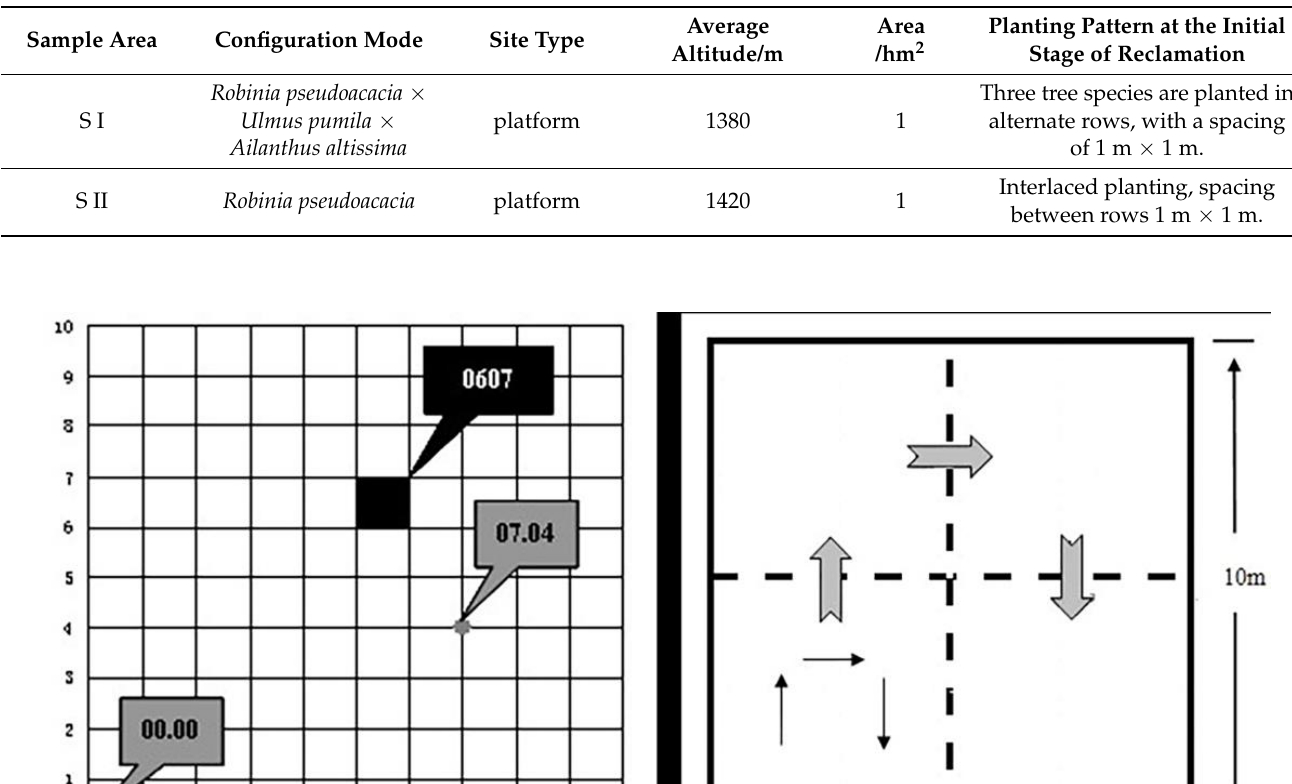
Table 1. Overview of permanently fixed monitoring plots.